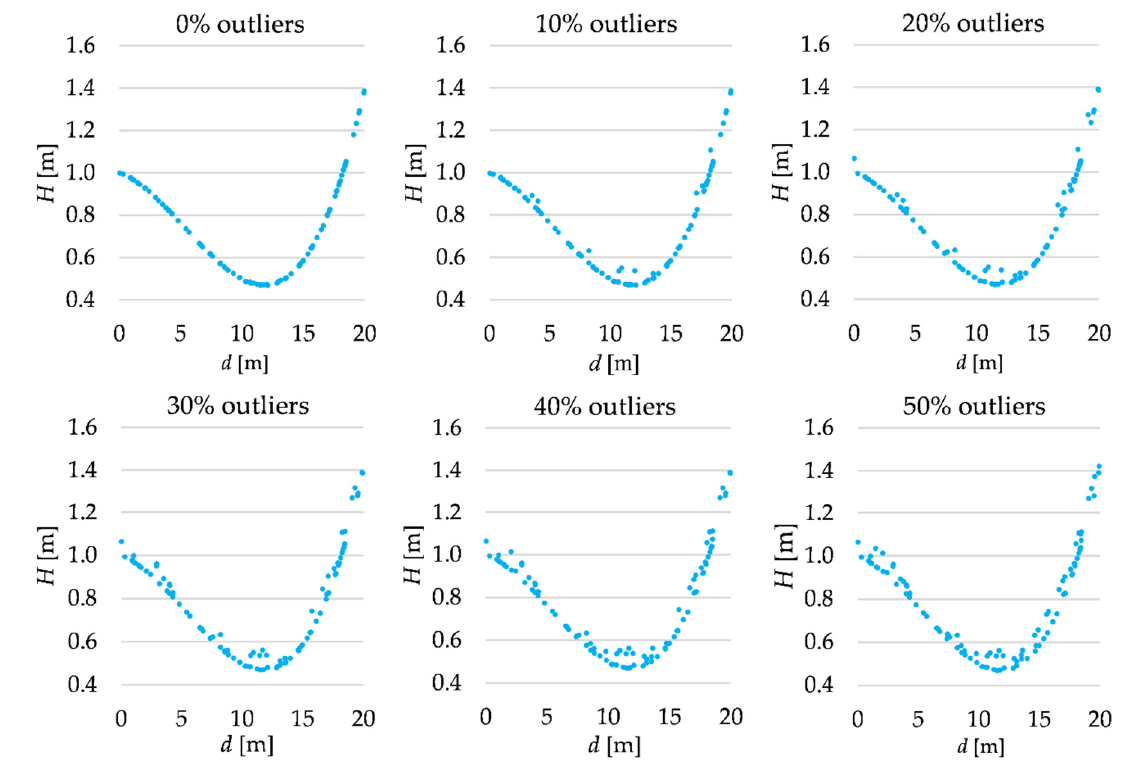
Figure 2. Simulated observation set (third-degree polynomial).